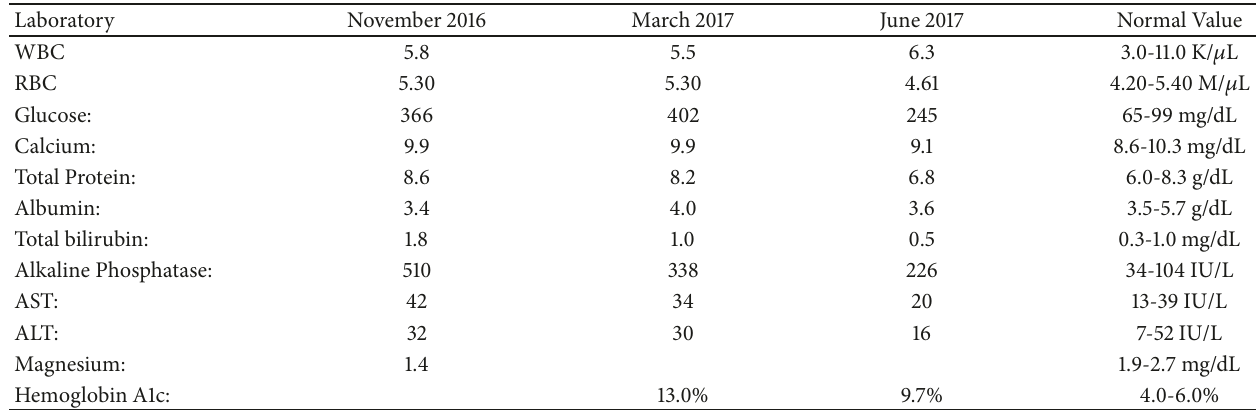
Table 1: Laboratory values at subsequent